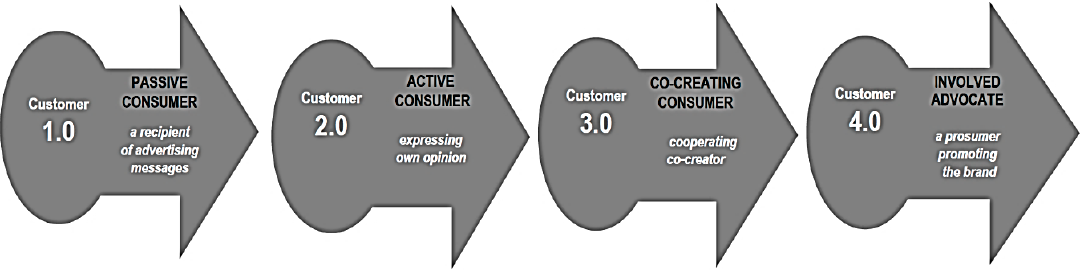
Figure 2. Changes in customer attitudes in relation to his / her market activity trough decades. Source: Own work based on (Nowacki 2014).